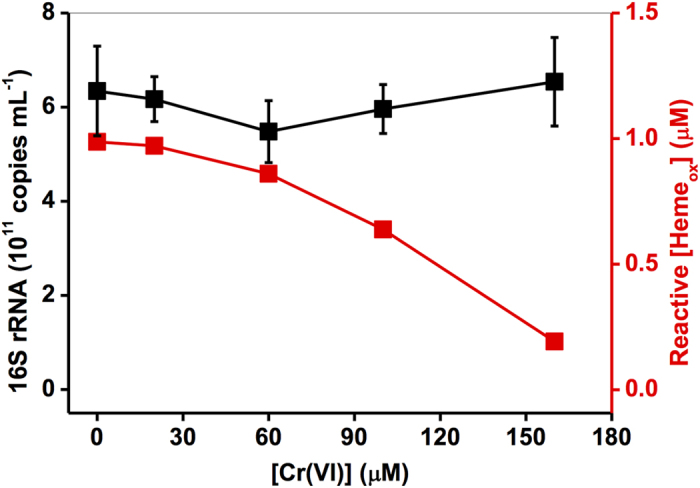
The 16S rRNA gene clone copies (black cubic-line) of SP200 (1.5 × 1011 cells mL−1) incubated in the presence of different concentrations of Cr(VI) for 40 min and the total reactive hemes (reactive [Hemeox]+[Hemered]) as a function of Cr(VI) concentrations. Cr(VI): 20 μM – 160 μM (red cubic-line). Error bars represents the standard deviation of the mean (n = 3).